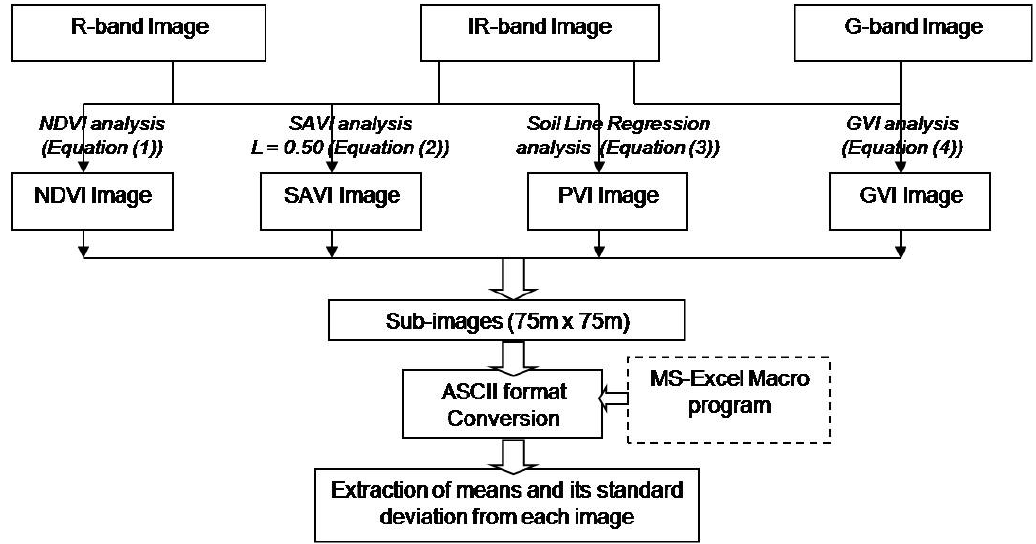
Figure 3. Schematic of working procedure for imagery input parameter extraction for BPNN